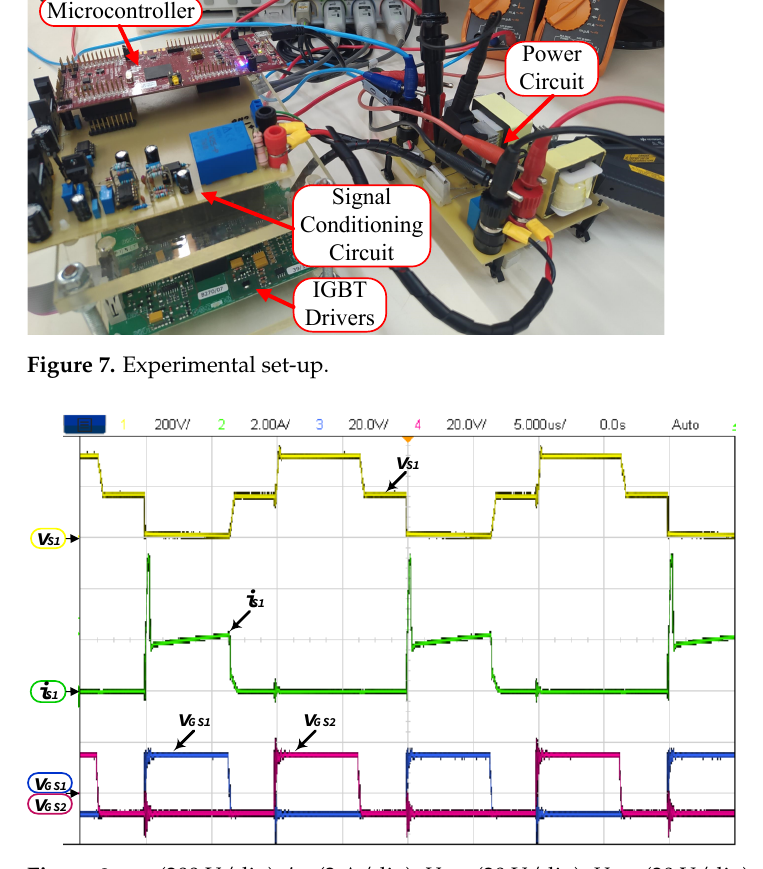
(200 V/div); i S 1